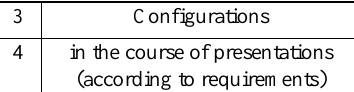
Table 5. Some steps for data processing of information systems (Köktürk, E. and Köktürk, E.